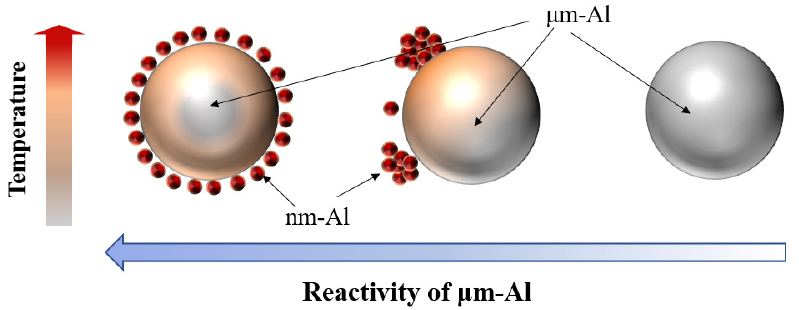
Figure 13. The reaction mechanism diagram of the micro-nano composite aluminum powder.